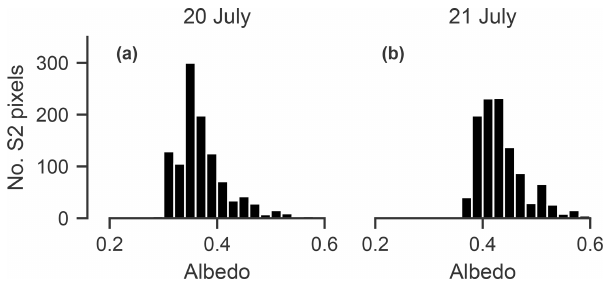
Figure 8. Histograms of S-2-derived albedo within the two MODIS pixels covering the UAS survey area on (a) 20 July and (b) 21